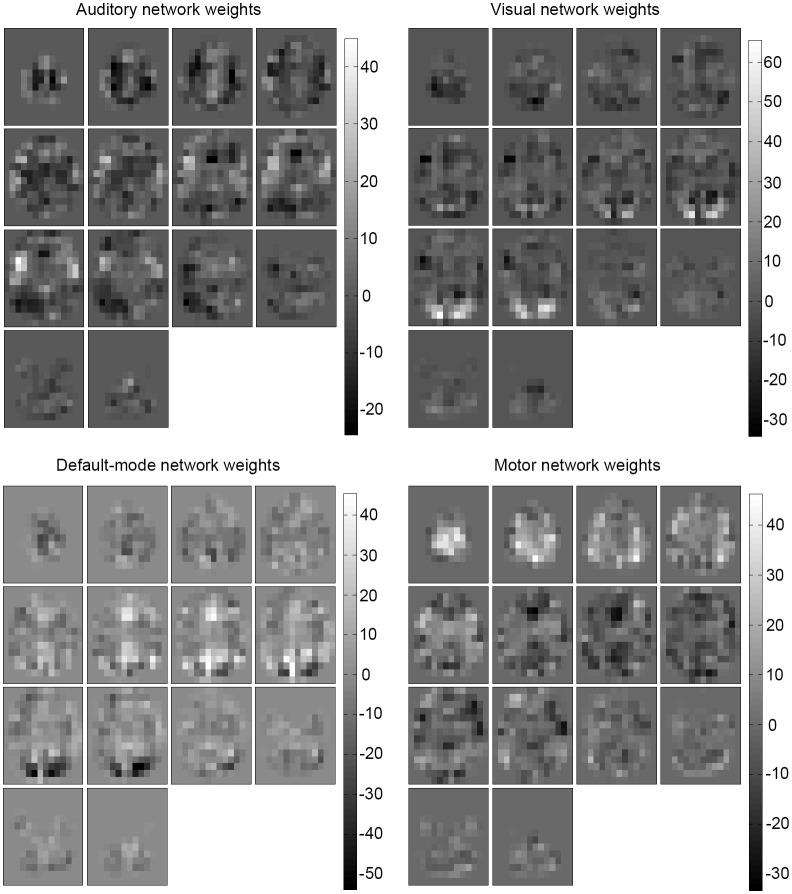
Learned weights for the perceptron. Learned weights for the perceptron classifier (healthy) are shown for each predicted network (executive control not shown). This reveals that the most influential areas correspond anatomically to their respective network location.